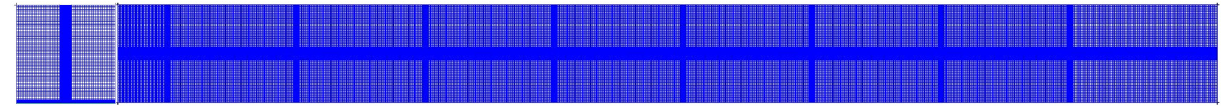
Figure 8. Grids distribution on the spanwise plane and streamwise plane under the incoming wind direction of 278°.